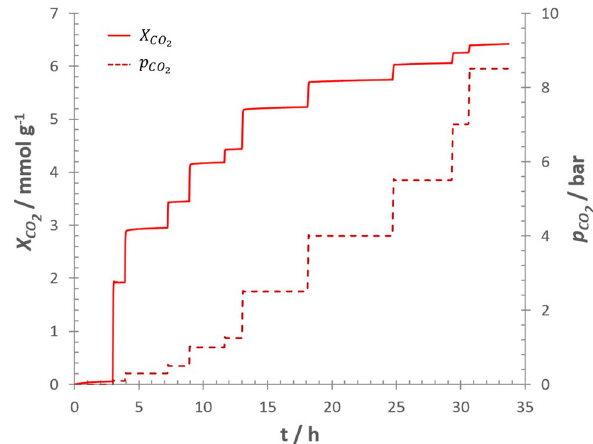
O with CO (red) 2 3 2 pressure profile of CO